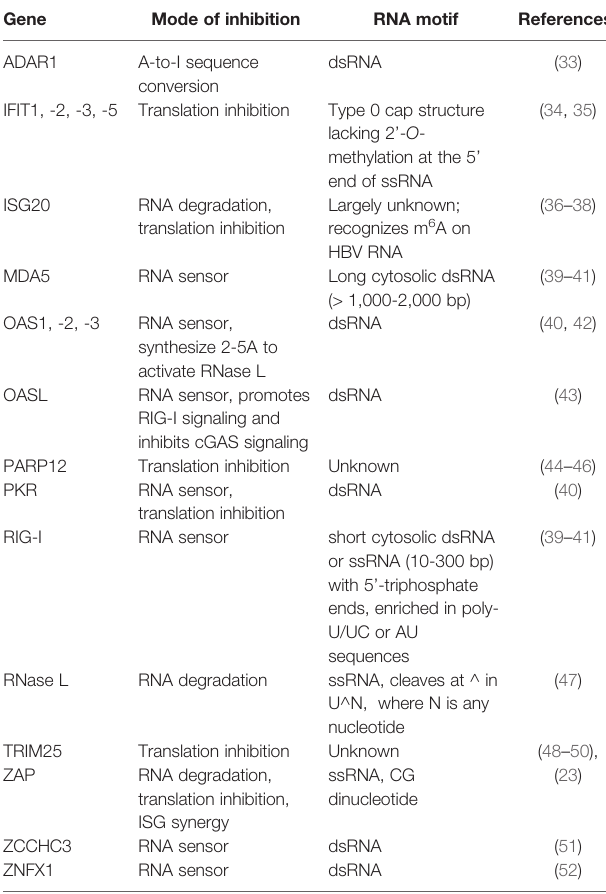
TABLE 1 | ISGs that must bind RNA to inhibit viral RNA processes.